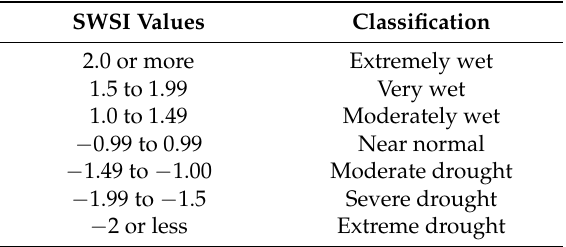
Table 2. Classification of the Standardized Water Storage Index